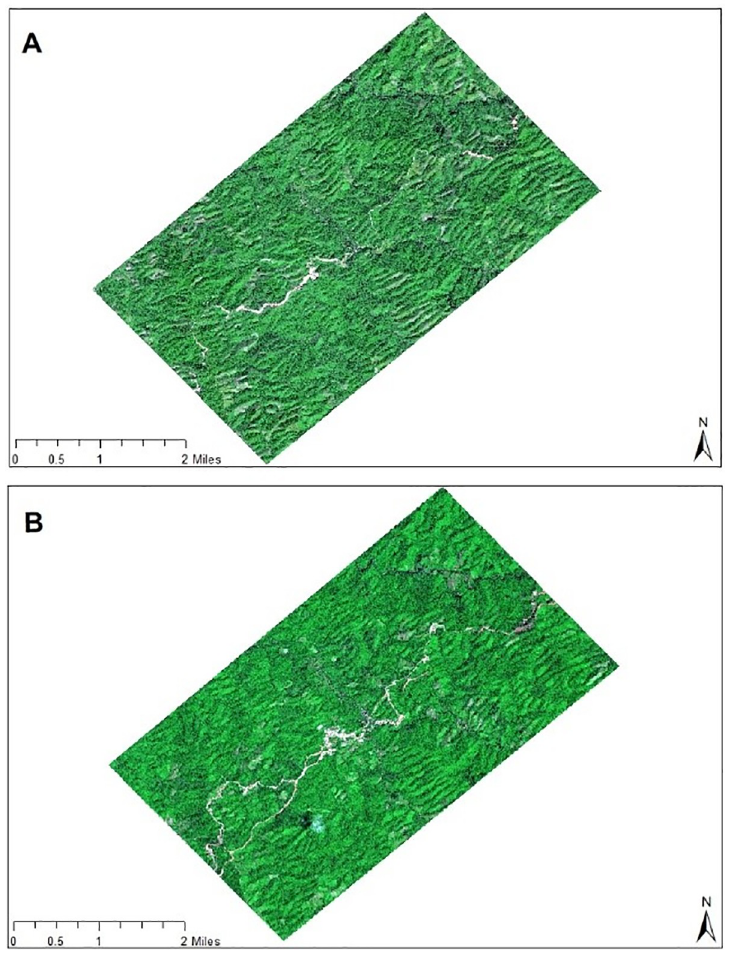
Fig 2. True color composite map of the study area pre- and post-construction of the China-Myanmar Oil and Gas pipelines. Image A is from 17 th November 2010, showing the area prior to the construction of the pipelines. Image B is from 17 th October 2012, showing the area after the construction of the pipelines. (DigitalGlobe order number: 059416456010_01) Source: http://www.digitalglobe.com.